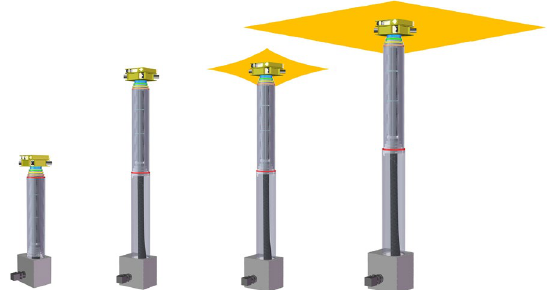
Figure 5 Workflow of TTM and solar